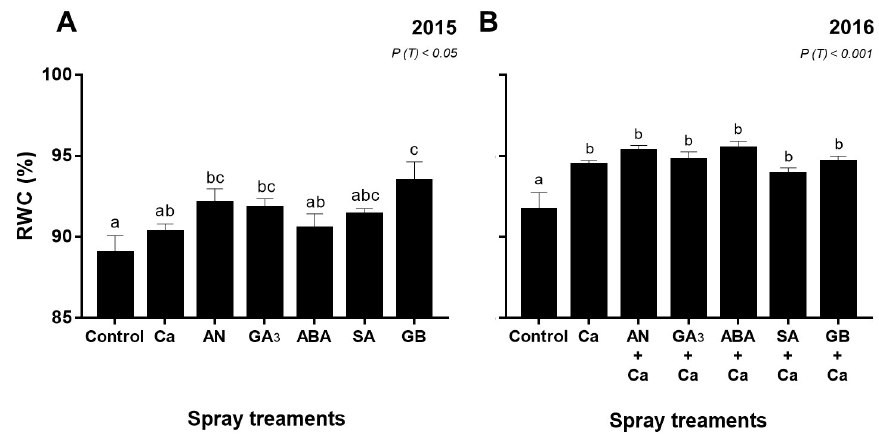
Figure 3. Relative water content (RWC, %) of ‘Skeena’ leaf cherry after spray treatments application in 2015 ( A ) and 2016 ( B ). Each column is expressed as mean ± SE (n = 6). Different letters indicate significant differences ( P < 0.05 ) among treatments by Duncan’s test.